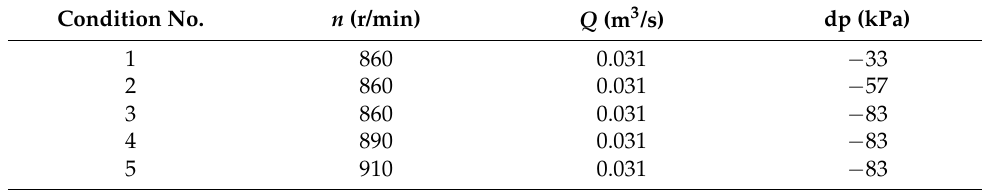
Table 1. Studied operating conditions